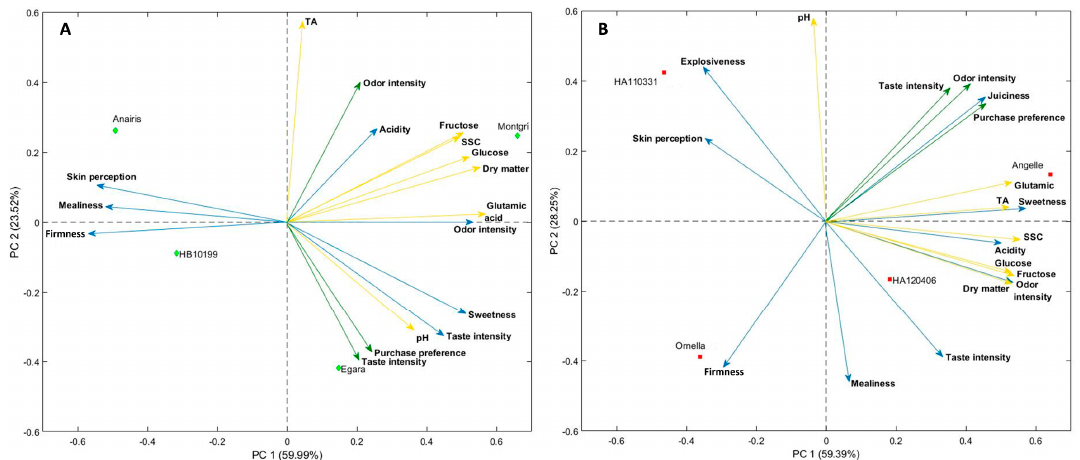
Figure 4. Plot of the two first principal components in the PCA estimated from sensory-panel, chemical, and consumer data on ( A ) fresh market and ( B ) cherry commercial groups. The type of variable is indicated in yellow (chemical), blue (trained panel), and green (consumer test) colors.